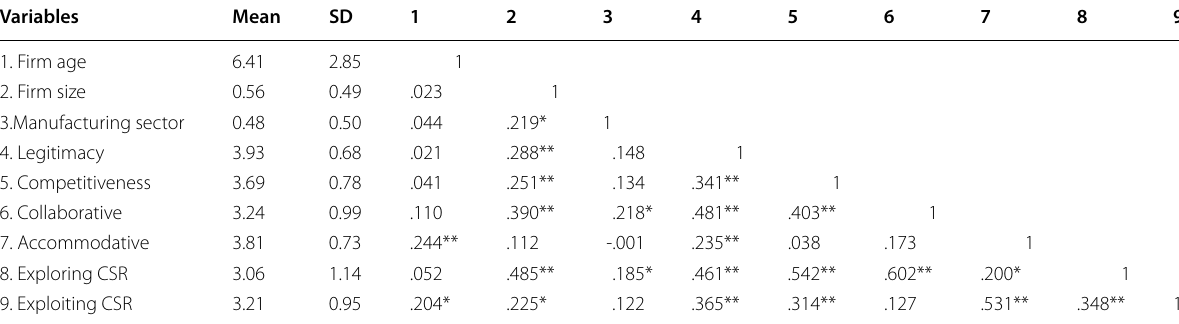
Source : Computed from survey data